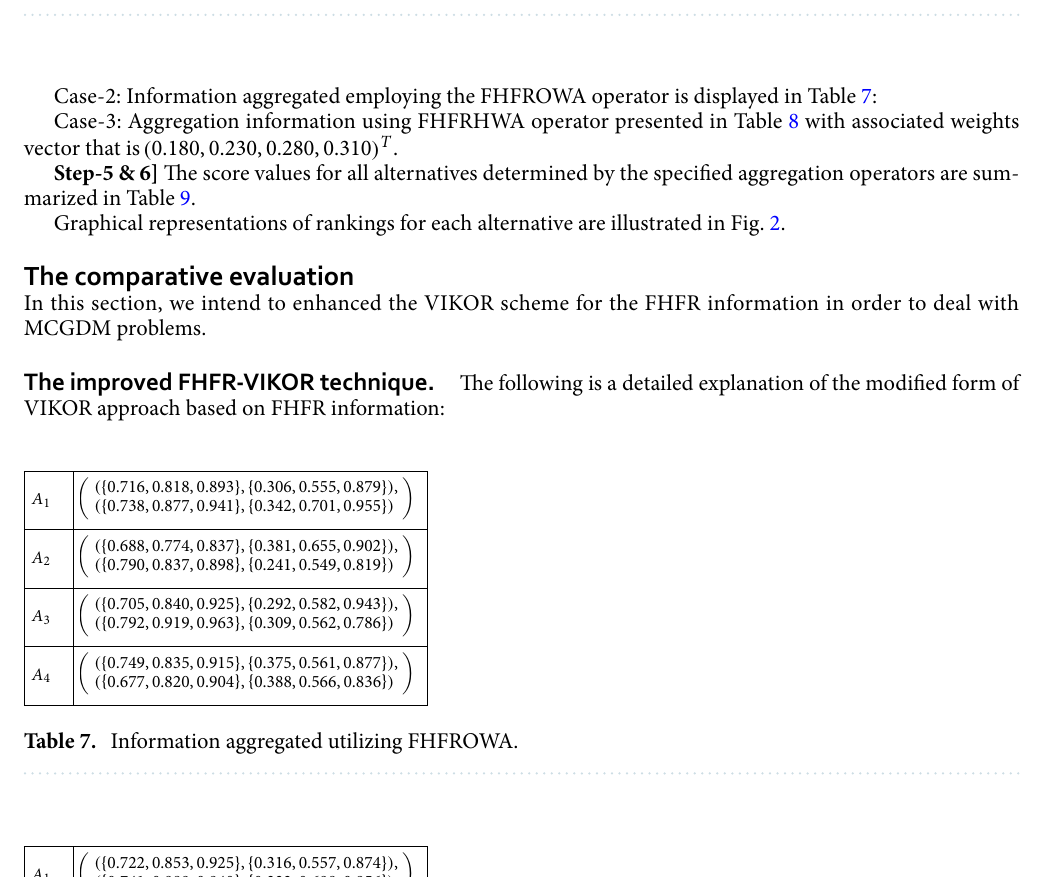
Table 6. Aggregated information using q -ROHFRWA.